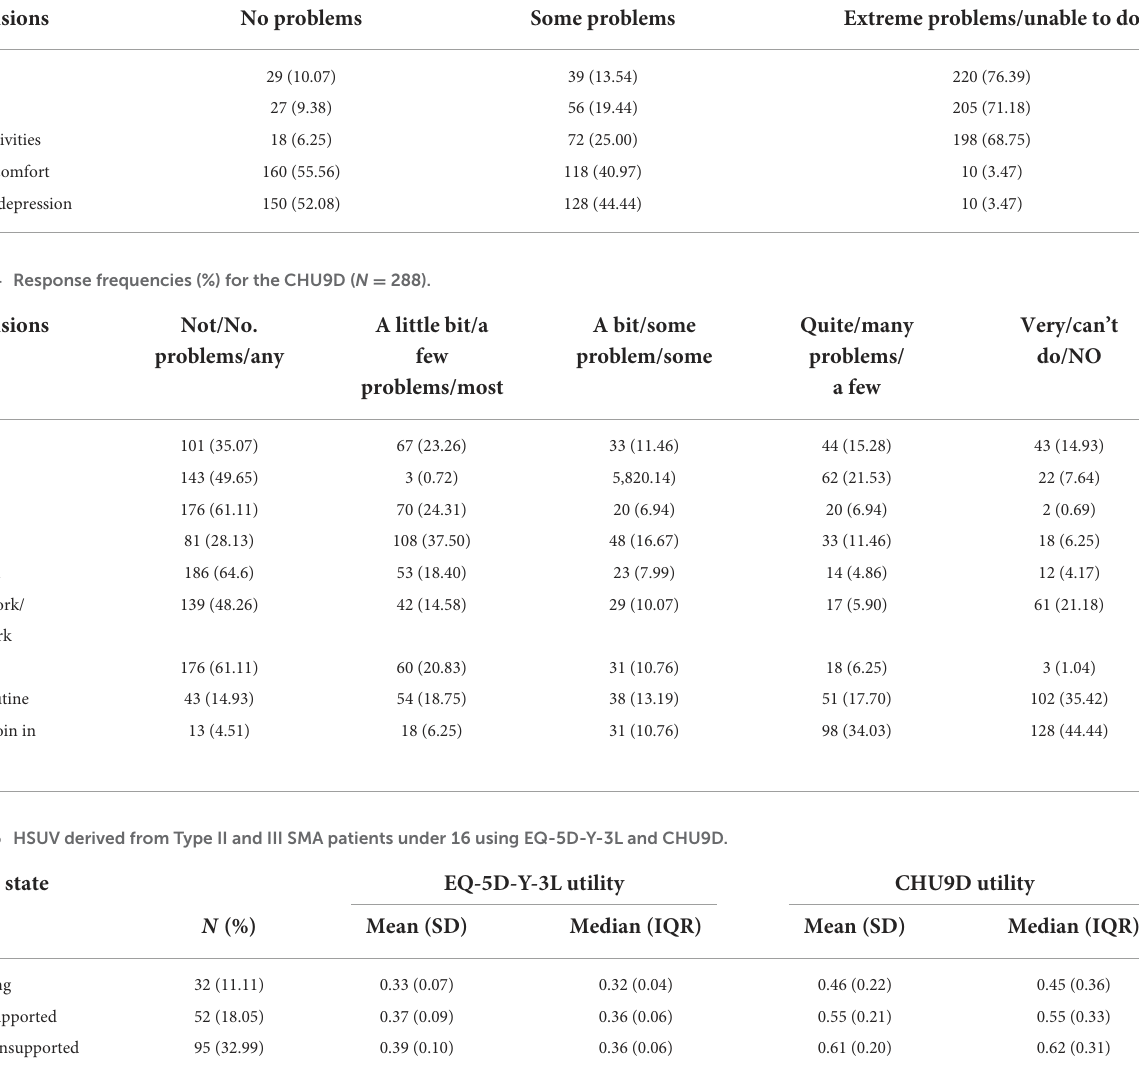
TABLE 3 Response frequencies (%) for the EQ-5D-Y-3L ( N = 288).